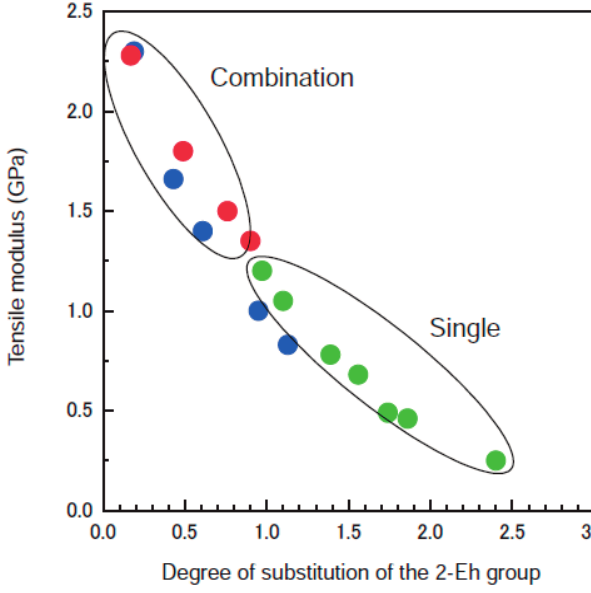
Figure 8. Tensile strength as a function of substitution using methyl/2-ethylhexanoyl (2-Eh) (blue), acetyl/2-Eh (red), and 2-Eh groups (green). Reprinted with permission from ref. [23]. Copyright 2012 FUJIFILM